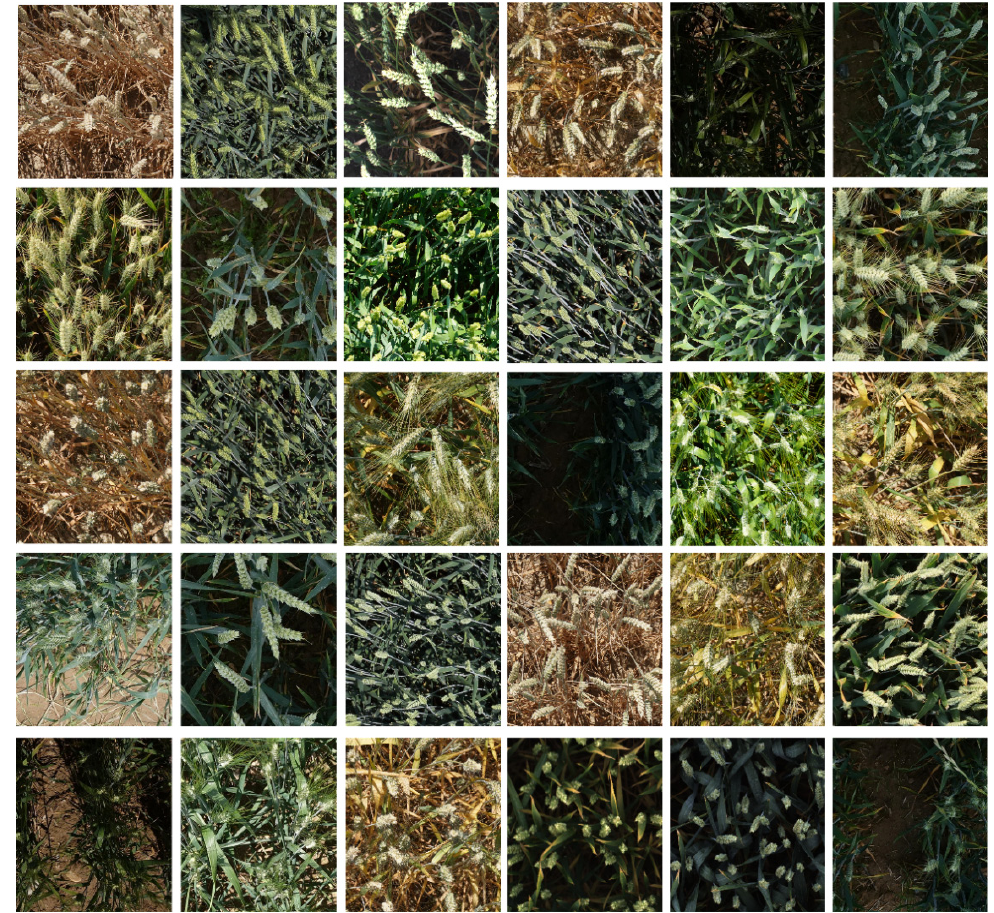
Figure 1. Part of the image data in the Global WHEAT